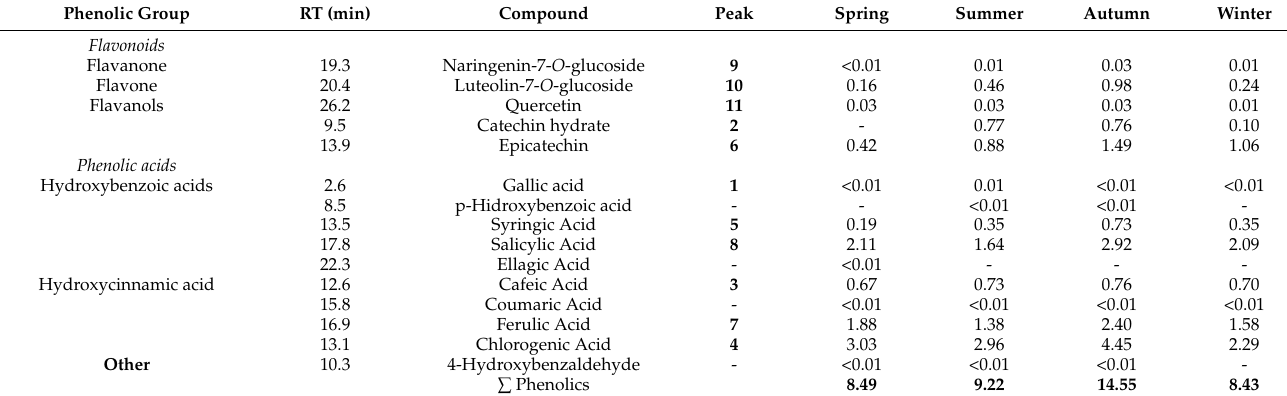
Table 2. HPLC-diode array detection (HPLC-DAD) identification and quantification (mg g − 1 extract) of the phenolic compounds of sawgrass ( C. mariscus ) extracts, for the different seasons. Peaks are numbered according to its retention time, in ascending order.